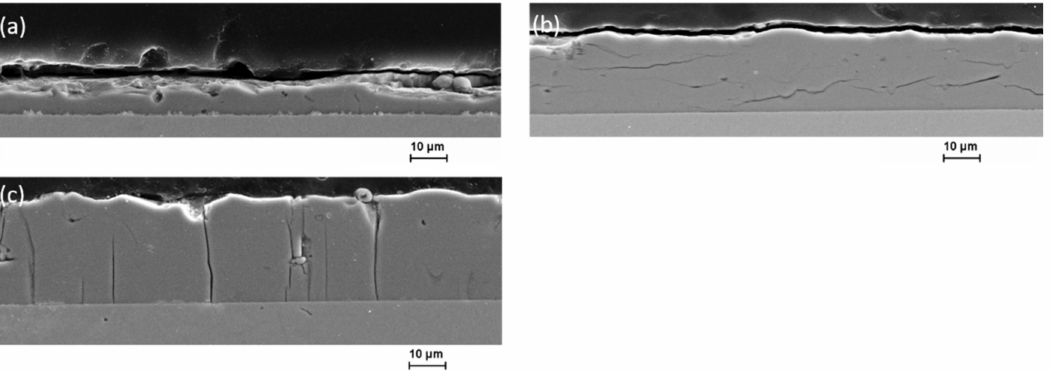
Figure 7. SEM micrographs of cross-sections of electrodeposited Fe-Cr-Ni coatings under DC 12 A/dm 2 conditions for three depositions ( a ) first deposition (2 h of electrolyte use) with clear material chipping; ( b ) second deposition (4 h of electrolyte use) with horizontal microcracks; and ( c ) third deposition (6 h of electrolyte use) with clear vertical microcracks.